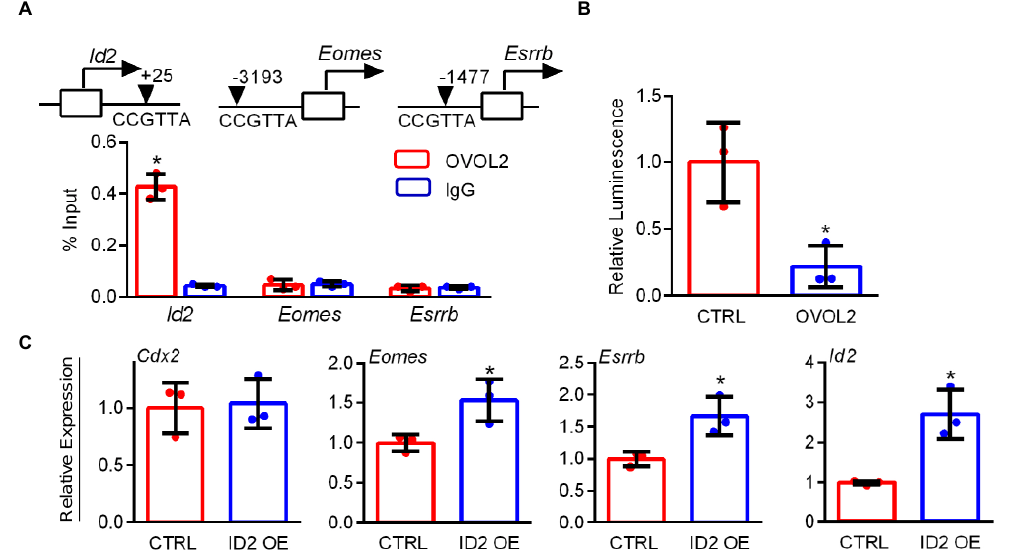
Figure 7. OVOL2 interacts with the Id2 gene. ( A ) ChIP was performed using OVOL2 or IgG (negative control) antibodies in lysates of mouse TS cells differentiated for 3 days. Quantitative PCR was used to detect enrichment, using primers spanning CCGTTA sequences near transcription start sites of Id2 , Eomes , and Esrrb . ( B ) Relative luciferase activity measured in HEK-293T cells transfected with Id2-Luc and either the CTRL plasmid or pEF-OVOL2-FLAG. ( C ) Quantitative RT-PCR showing relative expression of Cdx2 , Eomes , Esrrb , and Id2 in mouse TS cells transfected with CTRL or pEF-ID2-FLAG (ID2 OE). Values significantly different (N = 3, P < 0.05) from controls are indicated with an asterisk (*). Graphs represent means (SD).